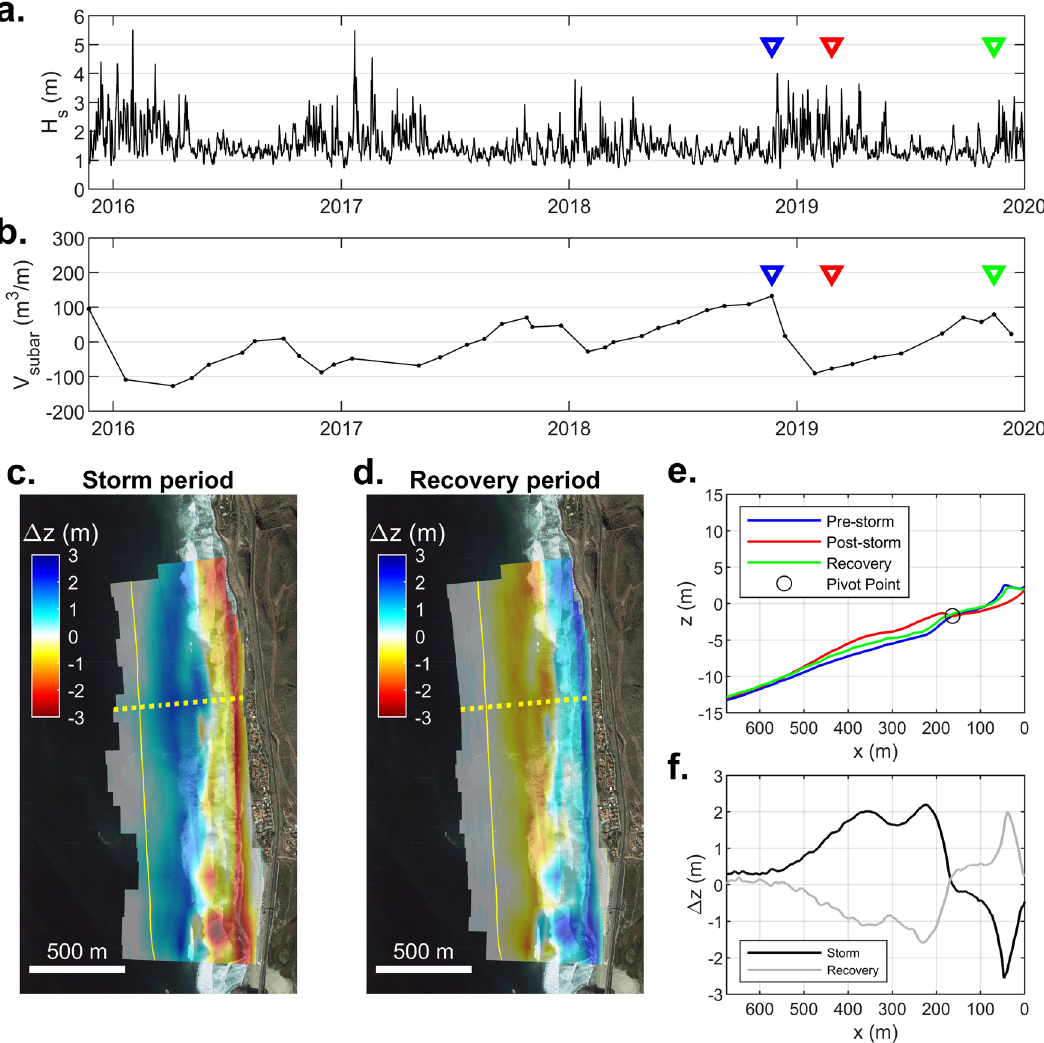
Fig. 5 Summary of wave and entire beach variability at La Misión, Mexico. a Deep-water signi fi cant wave height for La Misión (2015 – 2020) spanning the period of beach surveys. b Average subaerial volume change from beach surveys. Triangles in ( a , b ) denote the timing of pre-storm (blue), post-storm (red) and recovery (green) surveys. c Overall vertical change during the storm period; and d during the recovery period (depth of closure indicated by the solid yellow line). e A representative cross-shore transect indicating pre-storm, post-storm and recovery morphology; and f the vertical change over these two periods. Basemap data in ( c , d ) © 2022 Google (Imagery ©2022 Maxar